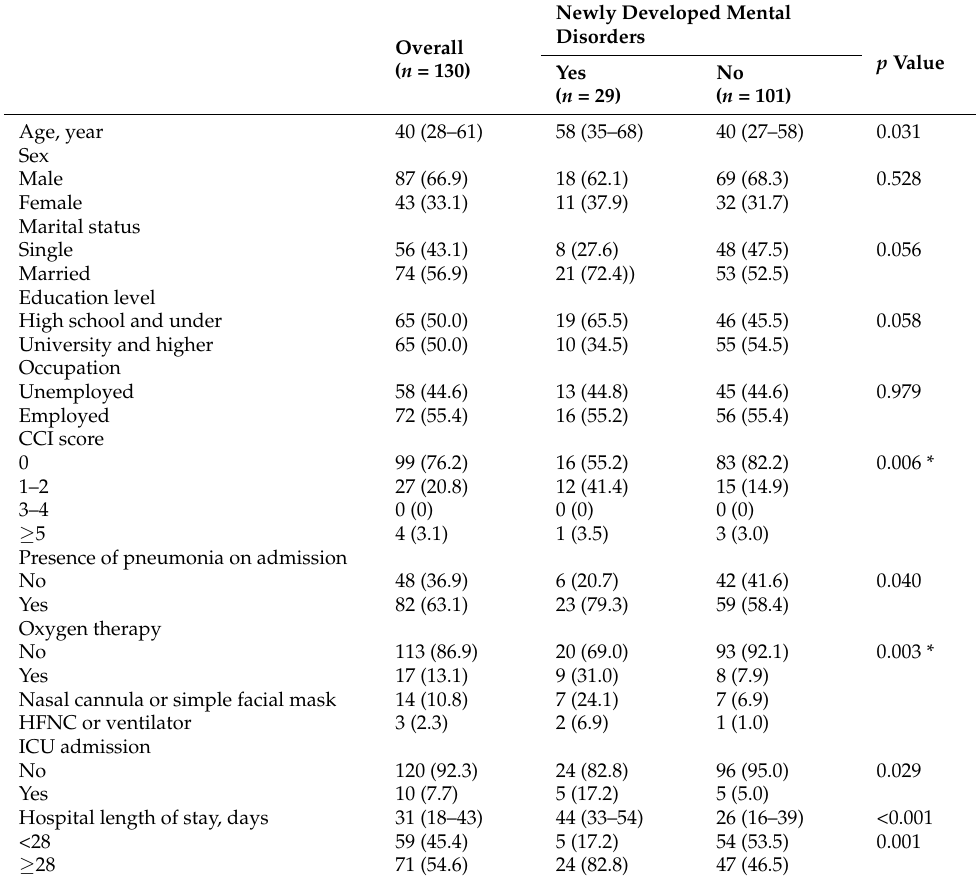
Table 1. Baseline characteristics of the patients according to new-onset (during hospitalization) mental disorder